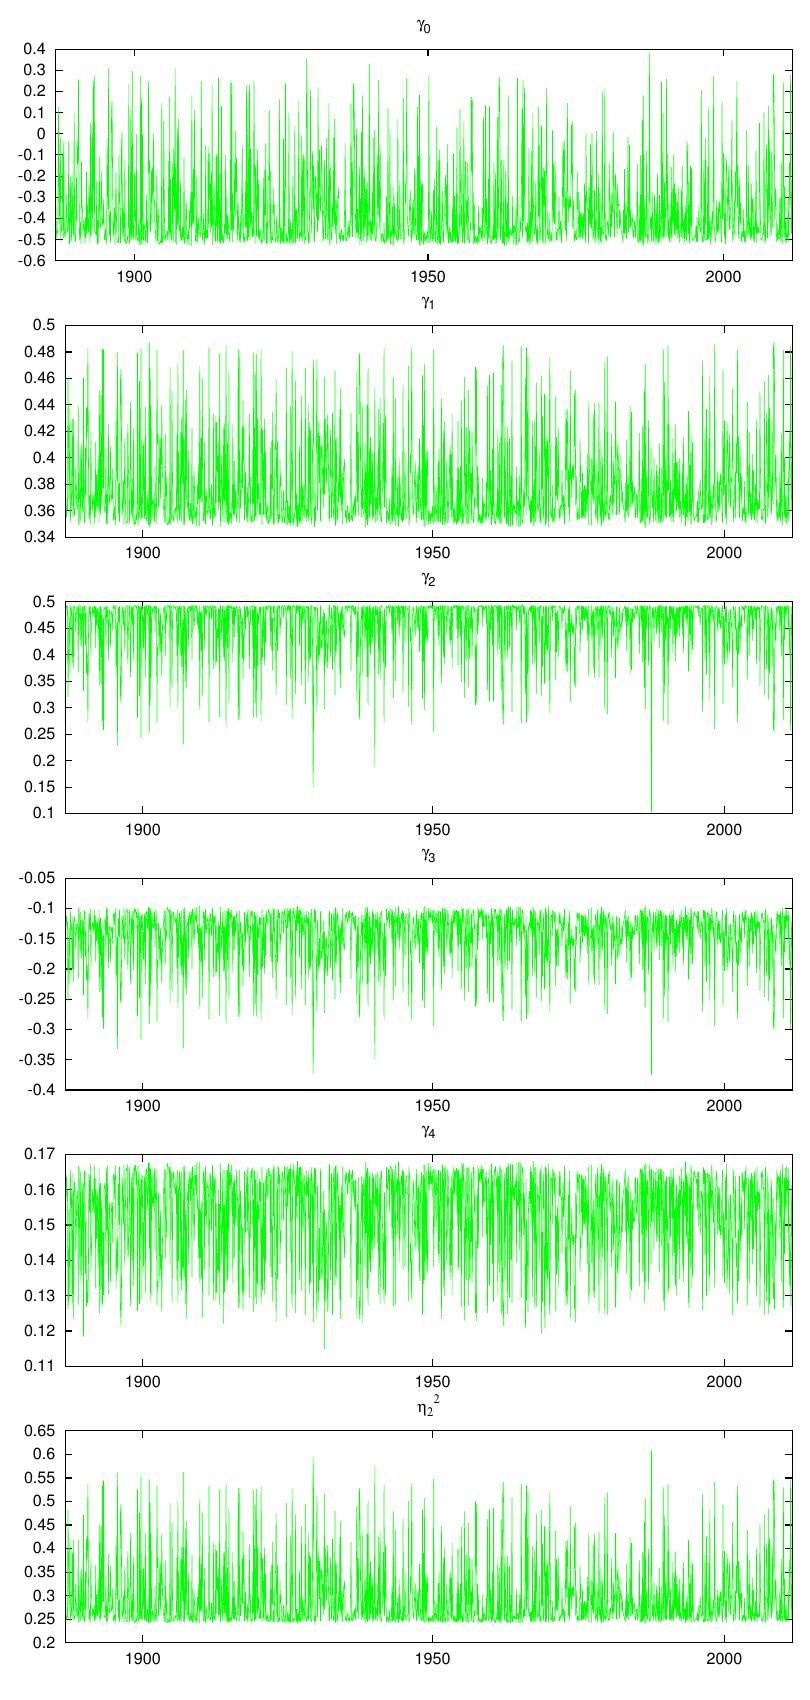
Figure 18. Posterior means of γ 0, s